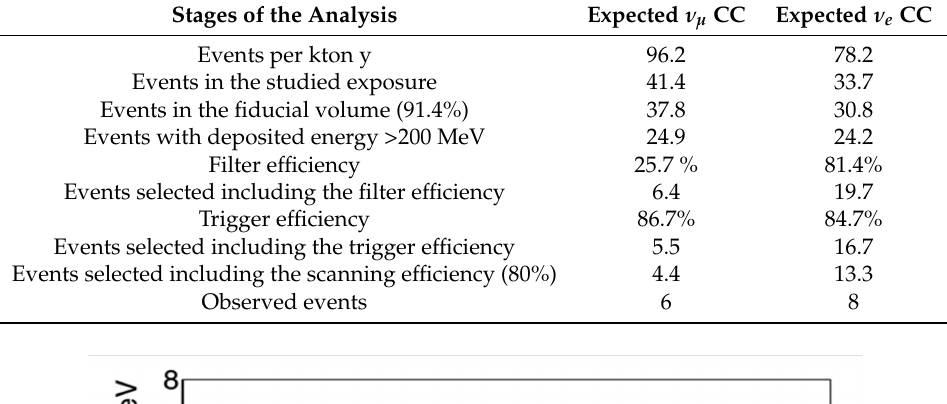
Figure 4. A clear atmospheric muon neutrino event with a deposited energy of 1.7 GeV is shown in the 2D collection view. The momentum of the 4-m escaping muon has been evaluated using an algorithm based on the multiple Coulomb scattering study [14], providing p= 1.8 ± 0.3 GeV/c. Two protons (deposited energy E dep ∼ 250 MeV) and a pion decaying in a muon followed by an electron ( E dep ∼ 80 MeV) are produced in the neutrino interaction vertex. A preliminary global reconstruction of the neutrino interaction provides E ν ∼ 2 GeV, with a zenith angle of ∼ 78 ◦ . Table 1. Expected number of neutrino interactions in the studied statistics, compared with the number of events identified by the filter in the collected data. The number of events per kton y has been evaluated assuming the standard 3 neutrino oscillations with ∆ m 2 23 = 2.5 × 10 − 3 eV 2 . The filter and scanning efficiency have been obtained using MC events, while the trigger efficiency has been directly evaluated on the cosmic ray events collected [5].